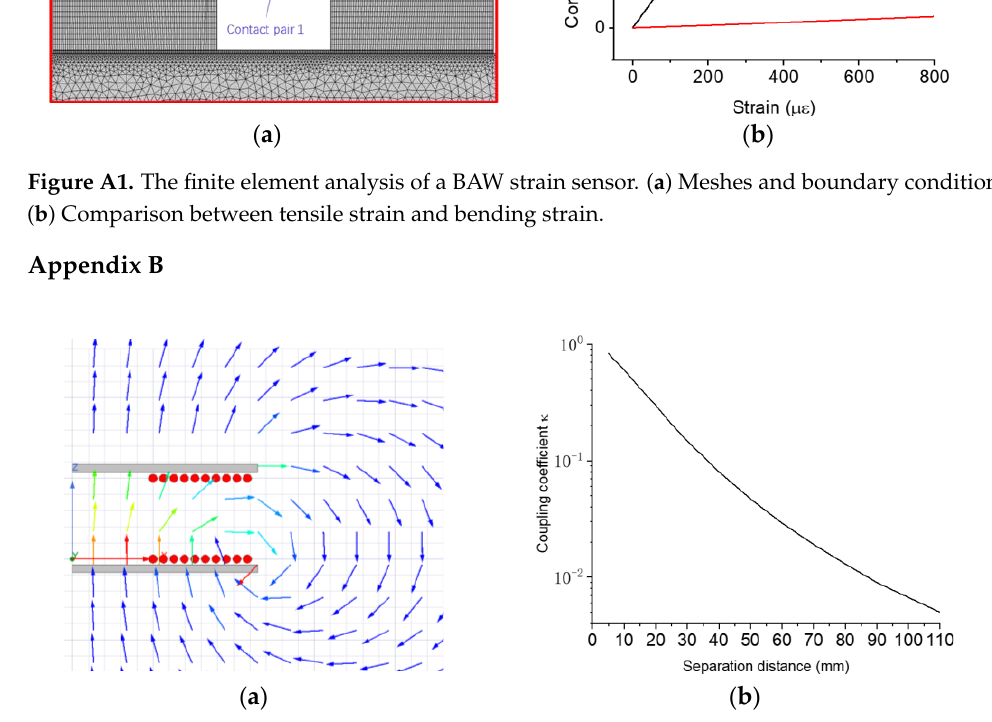
Figure A2. The numerical simulation of inductive coils. The software for FEM is ANSYS 2022. ( a ) A two-dimensional numerical model of two inductively coupled coils. The dimension of each coil is similar to the coil in the experiment. The colored arrows show the direction and strength of magnetic field intensity. The inductance of a simulated coil is 6.4 μH, which matches the measured inductance of coils. ( b ) The relationship between the coupling coefficient and the separation distance.